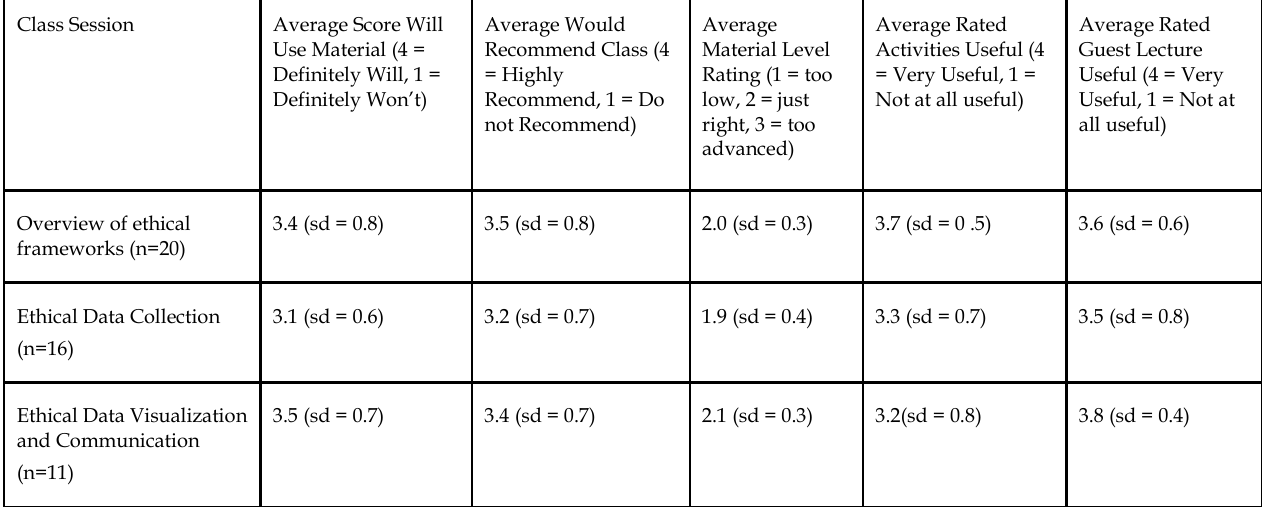
Table 2 Survey evaluation data from the three class sessions. Numbers refer to average score for each category, so a 4 would mean 100% responded with a 4. Specific ranges and meanings of each range are included in the header of each